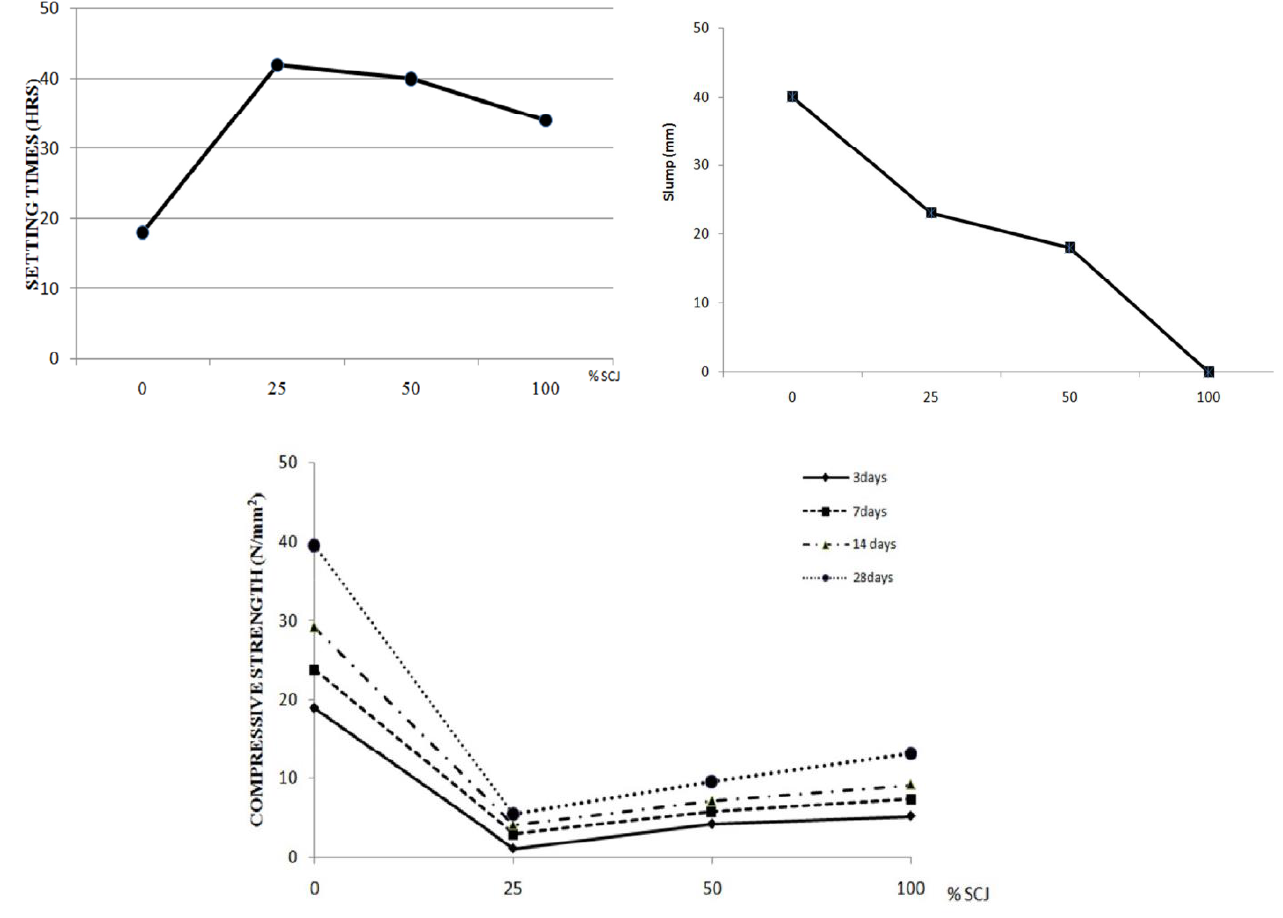
Figure 10. Test results sugar cane juice affects concrete properties (Otunyo et al.